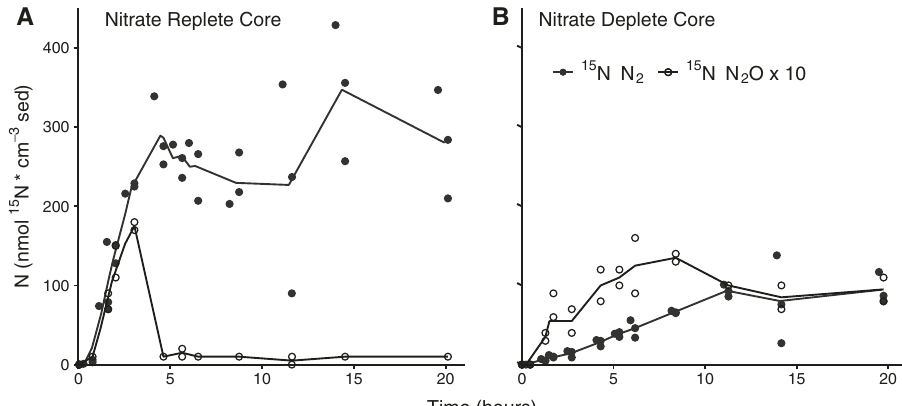
Fig. 7 N 2 O and N 2 production The production of N 2 (black circles) and N 2 O (open circles, values multiplied by 10) in the Nitrate Replete core ( A ) and Nitrate Deplete core ( B ) over the entire incubation time in nmol 15 N cm − 3 sediment. Lines connect the average value at each timepoint. Each point represents a measurement from a separate incubation. These incubations were carried out in October